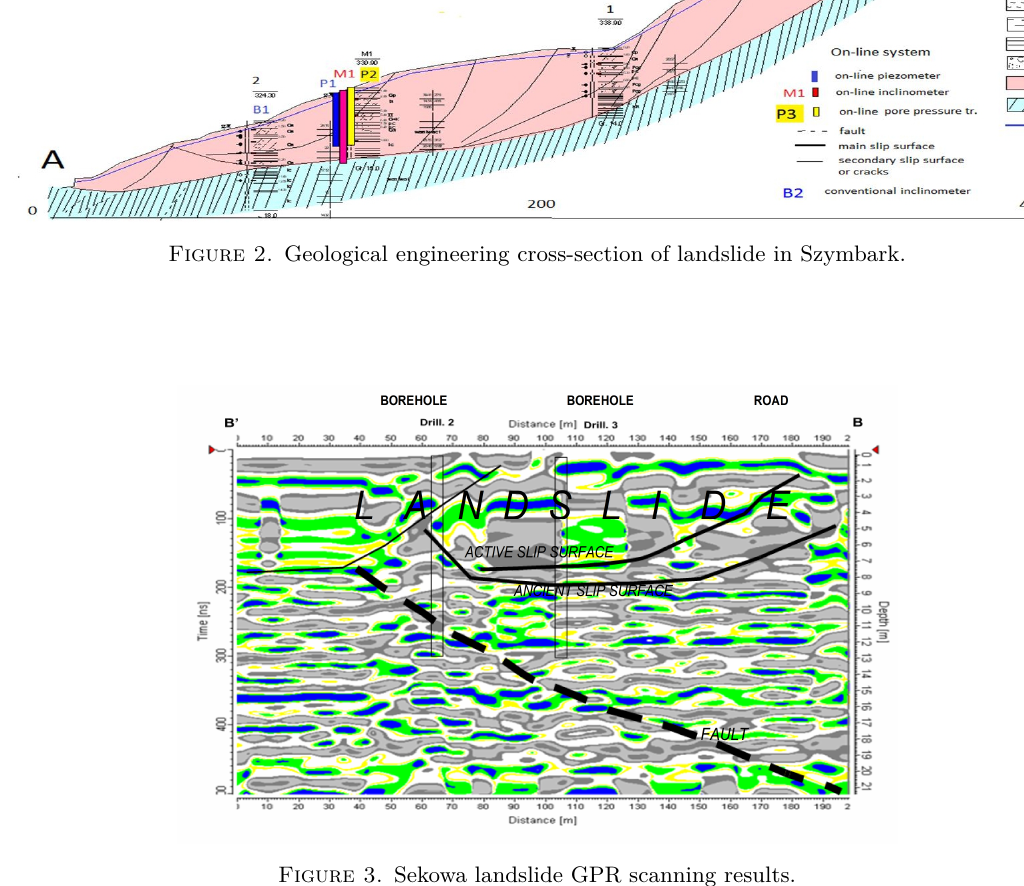
Figure 3. Sekowa landslide GPR scanning